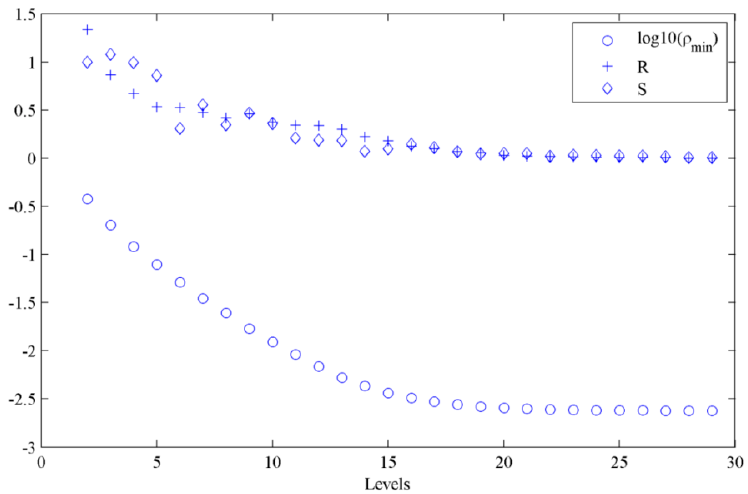
Figure 4. The convergence of the metric and the model parameters vector with the subset levels (case 1).